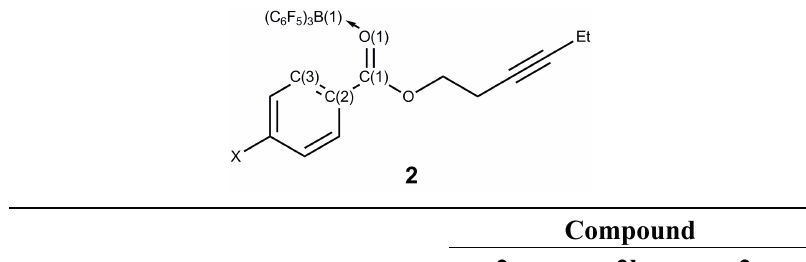
Table 2. Structural properties of 2a – c .